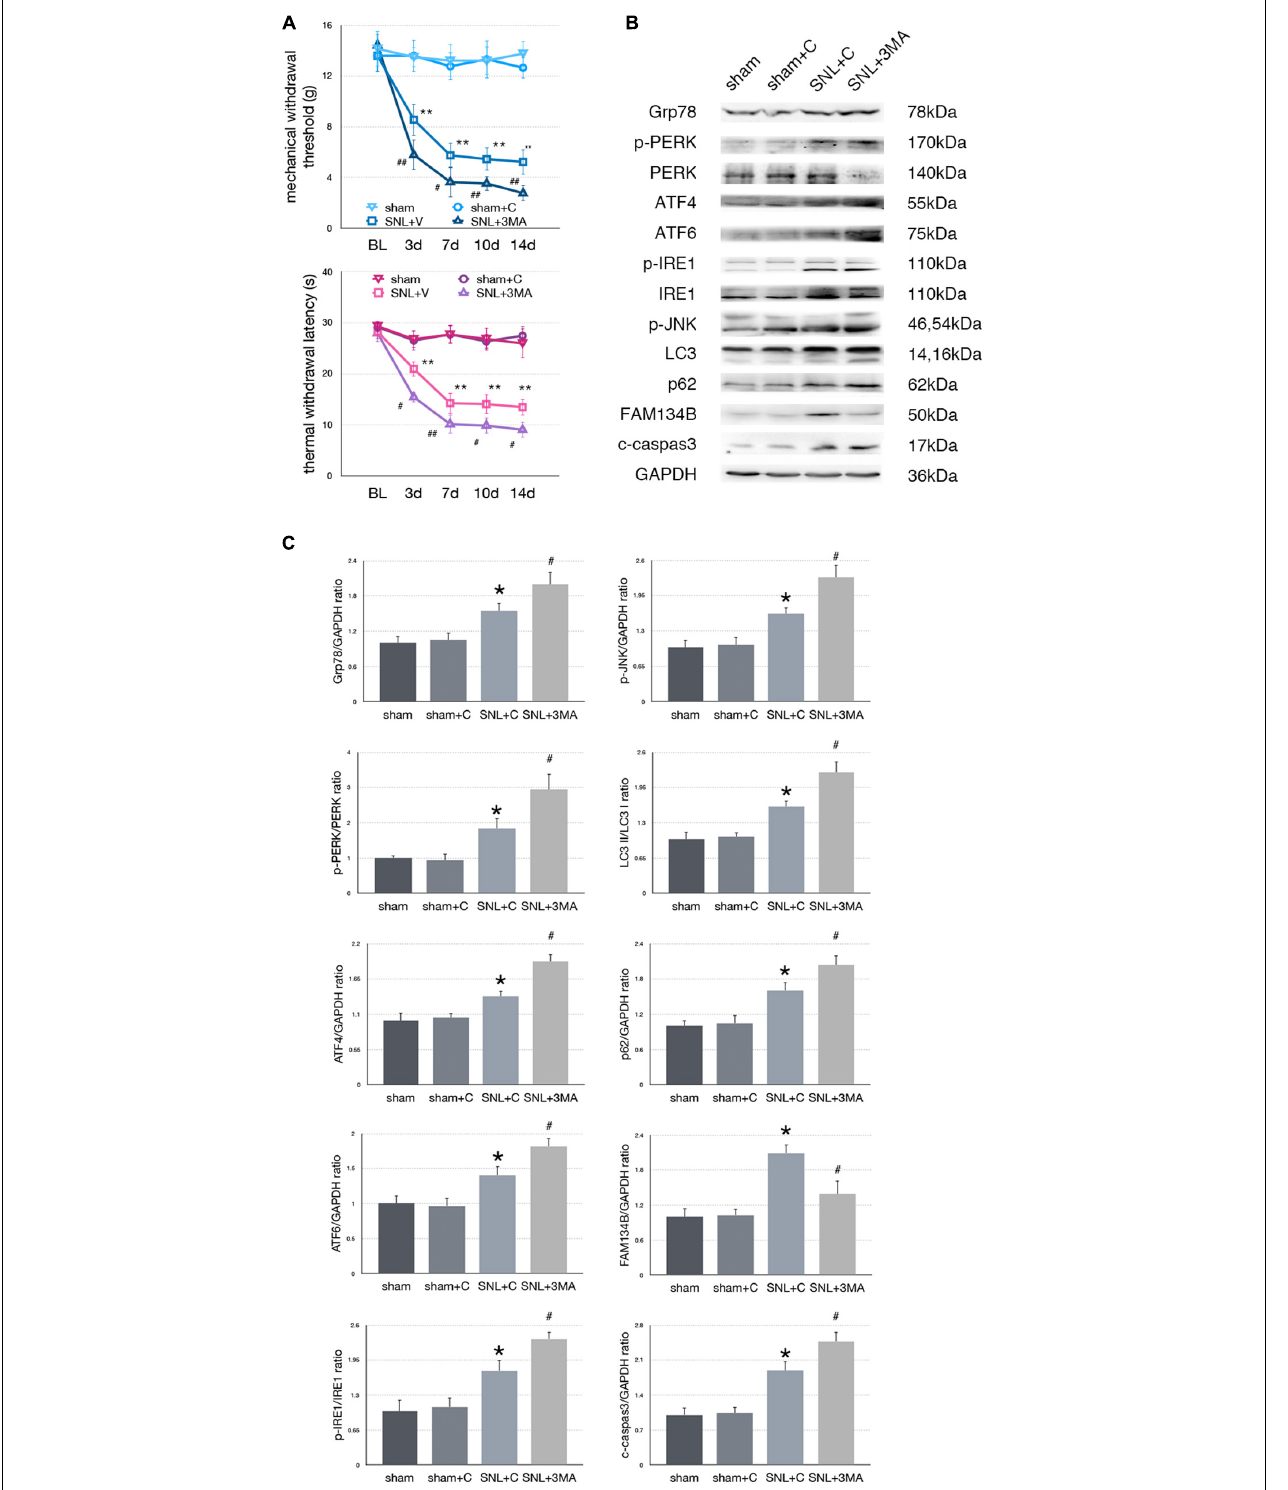
FIGURE 6 | Effect of 3-MA on pain related behavior tests and protein expression. (A) 3-MA injection deteriorates TWL and MWT tests in SNL rats. (B) 3-MA induces pro-death effect via exacerbating ER stress and ER-phagy impairment induced by SNL in spinal cord. (C) Quantifications of Western blot in sham, sham + C, SNL + C, and SNL + 3-MA groups. Protein expressions in spinal cord are shown. Data are presented as mean ± SD, n = 6 rats per group. sham vs. sham + C have no significant difference; * p < 0.05 SNL + C group vs. sham + C group; # p < 0.05 SNL + 3-MA vs. SNL + C group. In behavior tests, ** p < 0.01, ## p < 0.01.